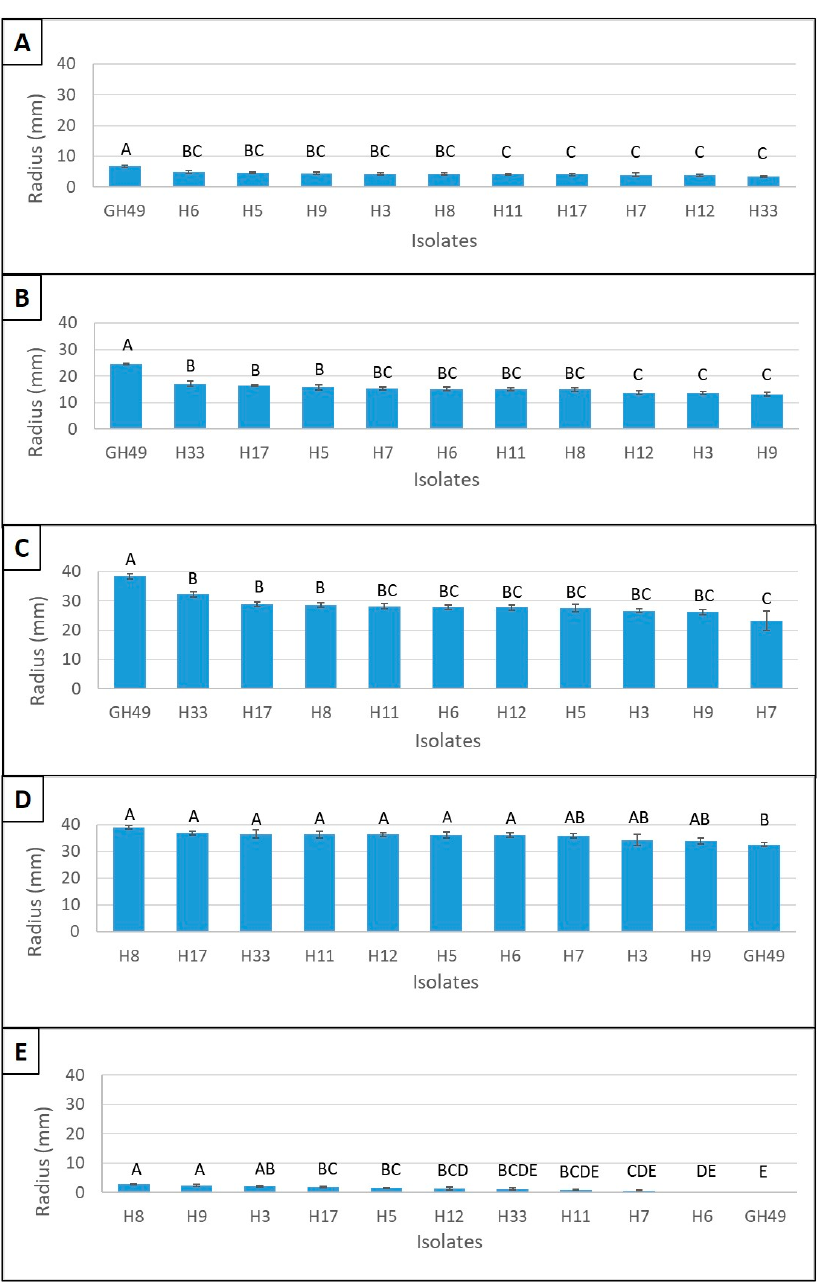
Figure 3. Effect of temperature on growth of Phytophthora palmivora . Mean radial growth after three days at ( A ) 15 ◦ C, ( B ) 20 ◦ C, ( C ) 25 ◦ C, ( D ) 30 ◦ C, and ( E ) 35 ◦ C of P. palmivora isolates from cacao in Hawaii ( n = 10) and Ghana ( n = 1; GH49). Columns with same letters above the bars are not significantly different ( p ≤ 0.05). No growth was observed at 10 ◦